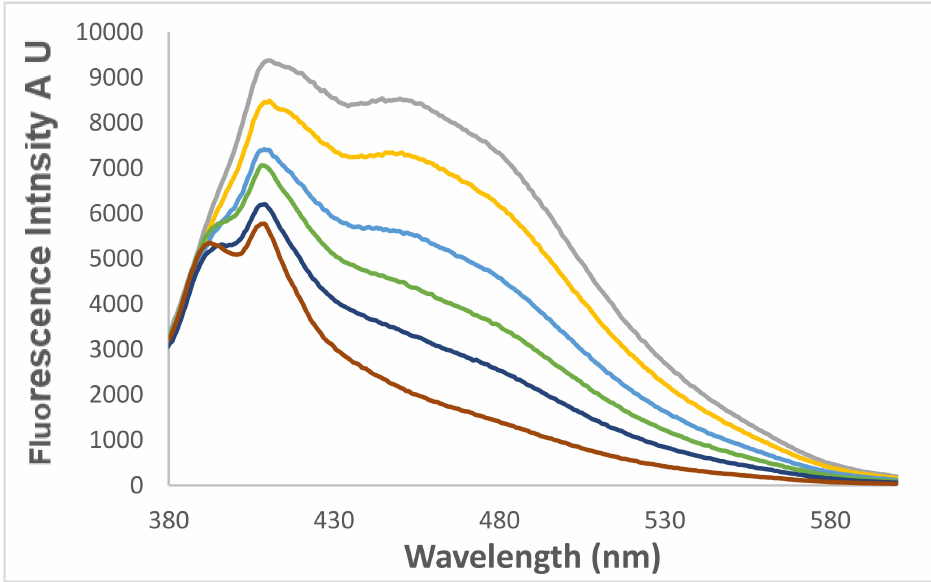
Figure 21. Fluorescence spectra of 2-amino-4-hydroxy-6-(4-hydroxy-2-oxo-2H-chromen-3- yl)nicotinonitrile 4 in ETOH increase in emission intensities at increasing